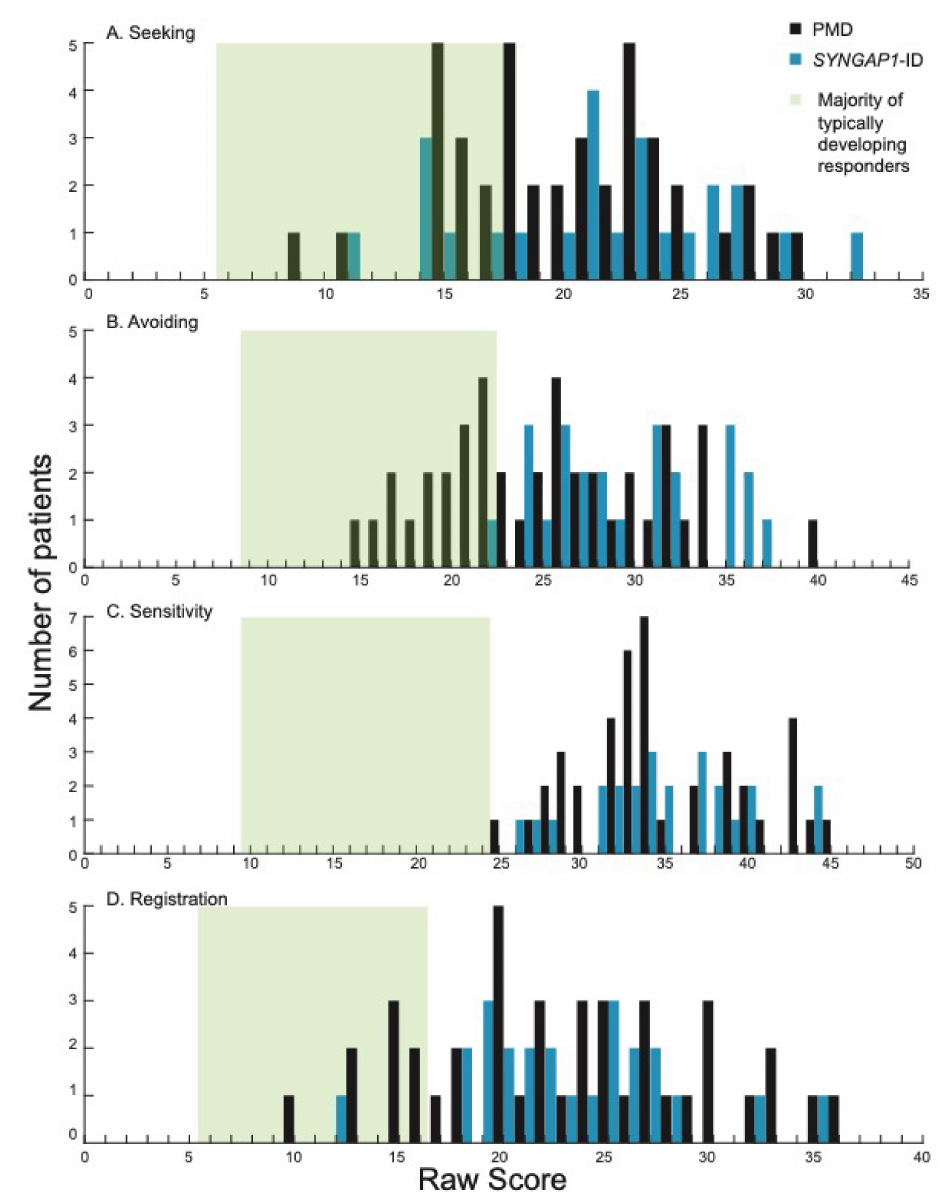
Figure 2. Distribution of scores in each of the four quadrants on the SSP-2 for PMD and SYNGAP1 - ID. Histograms showing number of PMD patients (black) and SYNGAP1 -ID patients (blue) with each raw score in the quadrants of ( A ) seeking, ( B ) avoiding, ( C ) sensitivity and ( D ) registration. Green box indicates range of scores associated with the majority of typically developing responders based on prior validation of the SSP-2 [24]. PMD: Phelan-McDermid Syndrome. SYNGAP1-ID: SYNGAP1-related Intellectual Disability. SSP-2: Short Sensory